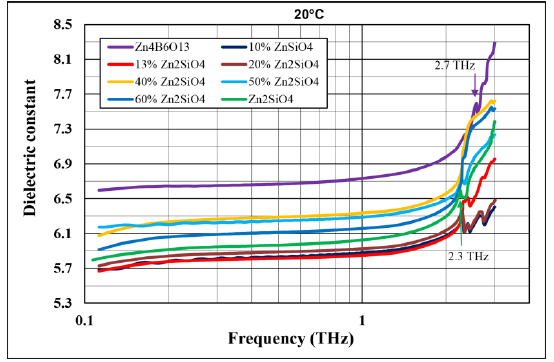
Figure 9. Comparison of dielectric constant at 20 °C as a function of frequency in the range 0.12–3 THz for Zn 4 B 6 O 13 , Zn 2 SiO 4 , and Zn 4 B 6 O13–Zn 2 SiO 4 ceramics.